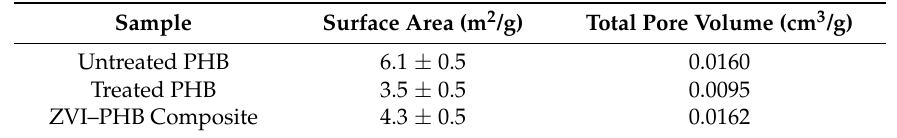
Table 1. Surface areas and total pore volumes of commercial untreated PHB (polyhydroxybutyrate), thermally treated PHB, and ZVI (zero ‐ valent iron)–PHB composite (ZVI/PHB ratio 1:2 w / w ).